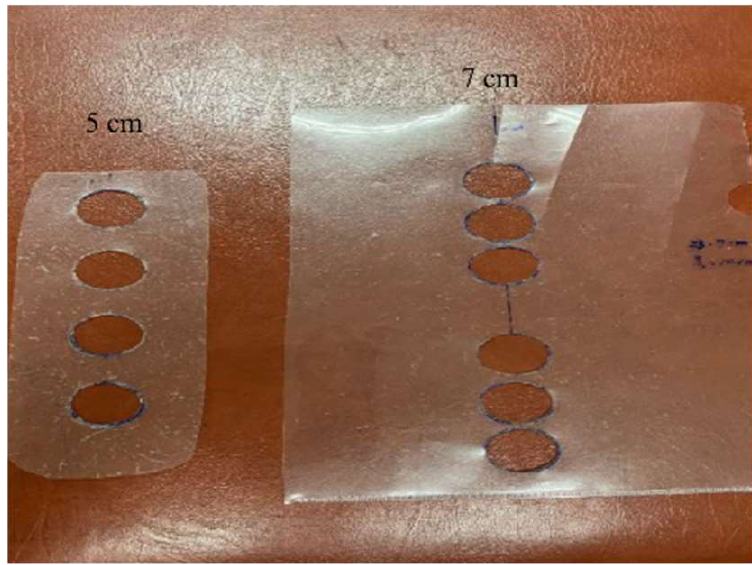
Figure 3. Calibrations of BIOPAC EP 100 module. ( a ) Calibration of resistance with a resister box. ( b ) Calibration of reactance with a capacitor box.